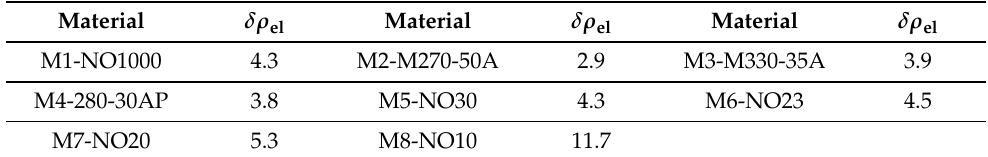
Table 3. Estimated measurement error δρ el ( ϑ = 293K ) in